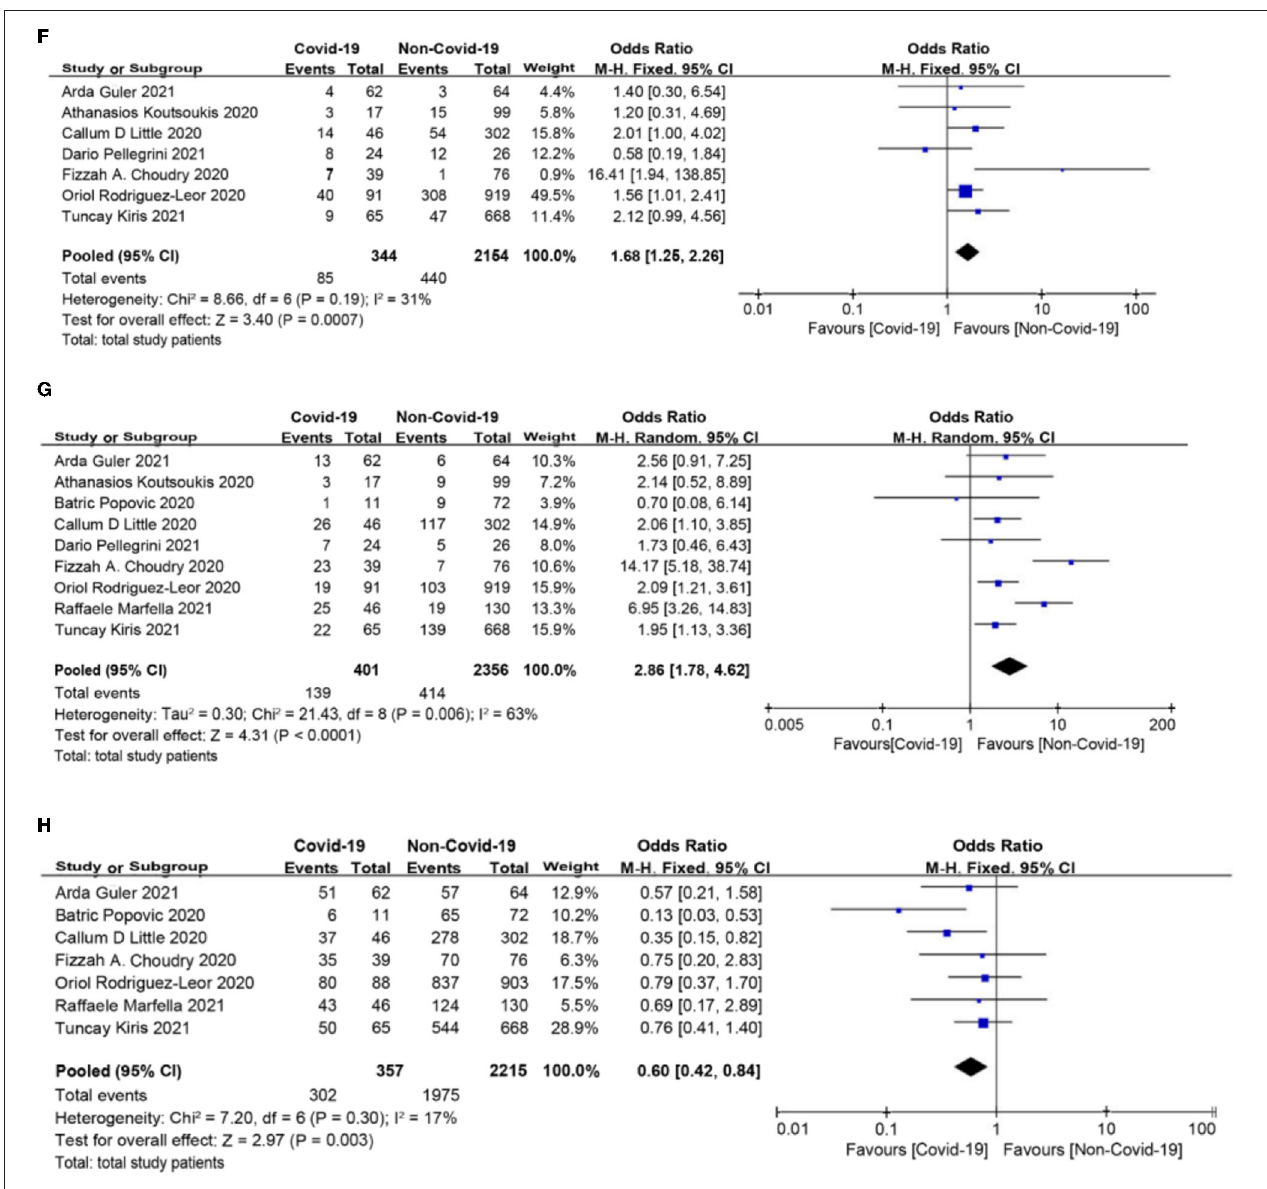
FIGURE 4 | (A) Primary angioplasty forest plot. (B) Myocardial infarction with no obstructive coronary atherosclerosis (MINOCA) forest plot. (C) Stent implantation forest plot. (D) Baseline thrombus grade forest plot. (E) Modified thrombus grade forest plot. (F) Thrombus aspiration forest plot. (G) Glycoprotein IIbIIIa (Gp2b3a) inhibitor use forest plot. (H) Thrombolysis in myocardial infarction (TIMI)-3 flow forest